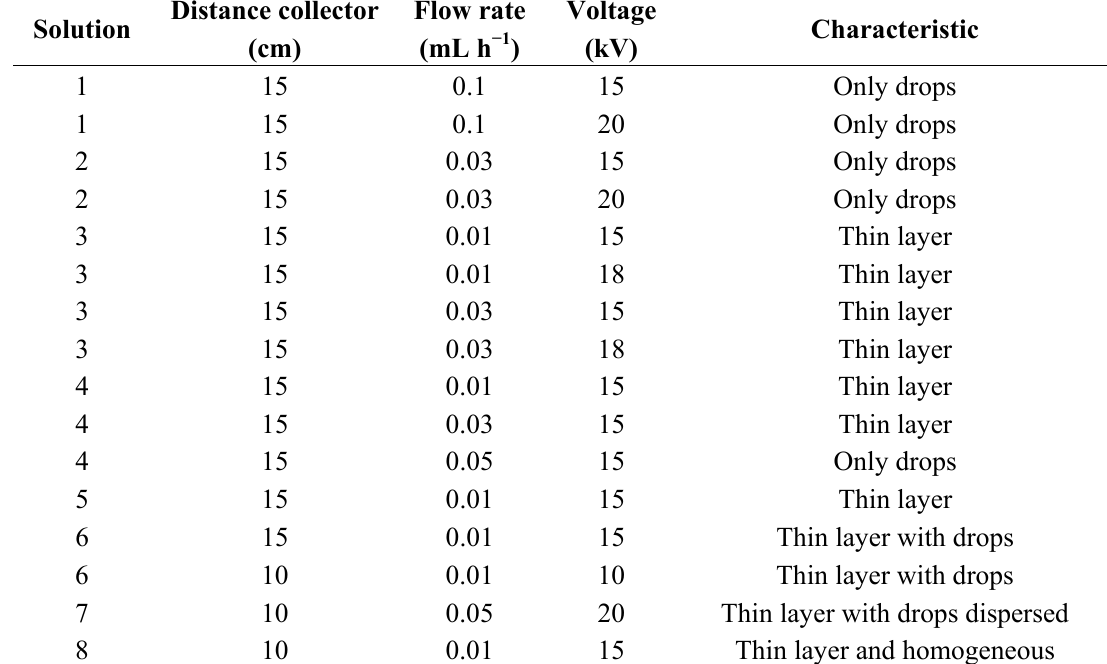
Table 1. Electrospinning conditions for the preparation of membranes from wheat gluten.